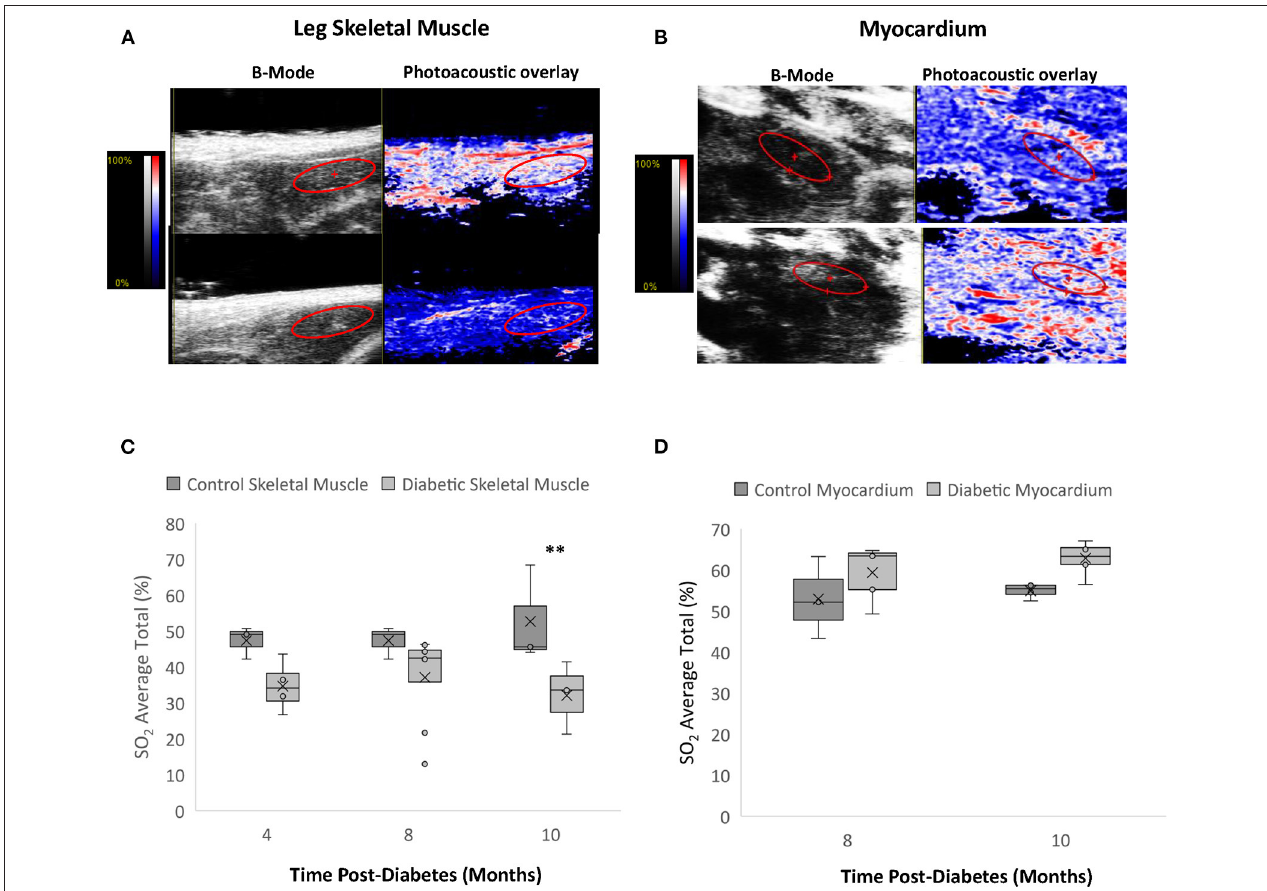
FIGURE 8 | Photoacoustic imaging in leg skeletal muscle and myocardium. (A) Photoacoustic ultrasound images of male control (top) and diabetic (bottom) skeletal muscle at 10 months post-diabetes. Greyscale images are B-Mode images, and colormaps are the photoacoustic blood oxygenation saturation overlay. (B) Photoacoustic ultrasound images of male control (top) and diabetic (bottom) cardiac muscle at 10 months post-diabetes. (C) Blood oxygen saturation average in skeletal muscle at 4 months ( n = 3 control and n = 4 diabetic), 8 months ( n = 3 control and n = 8 diabetic), and 10 months ( n = 4 control and n = 6 diabetic) post-diabetes. (D) Blood oxygen saturation average in the myocardium at 8 months ( n = 3 control and n = 5 diabetic) and 10 months ( n = 4 control and n = 6 diabetic) post-diabetes. Box plot mean value is represented with the symbol “X.” Significance at individual timepoints is indicated (** p <